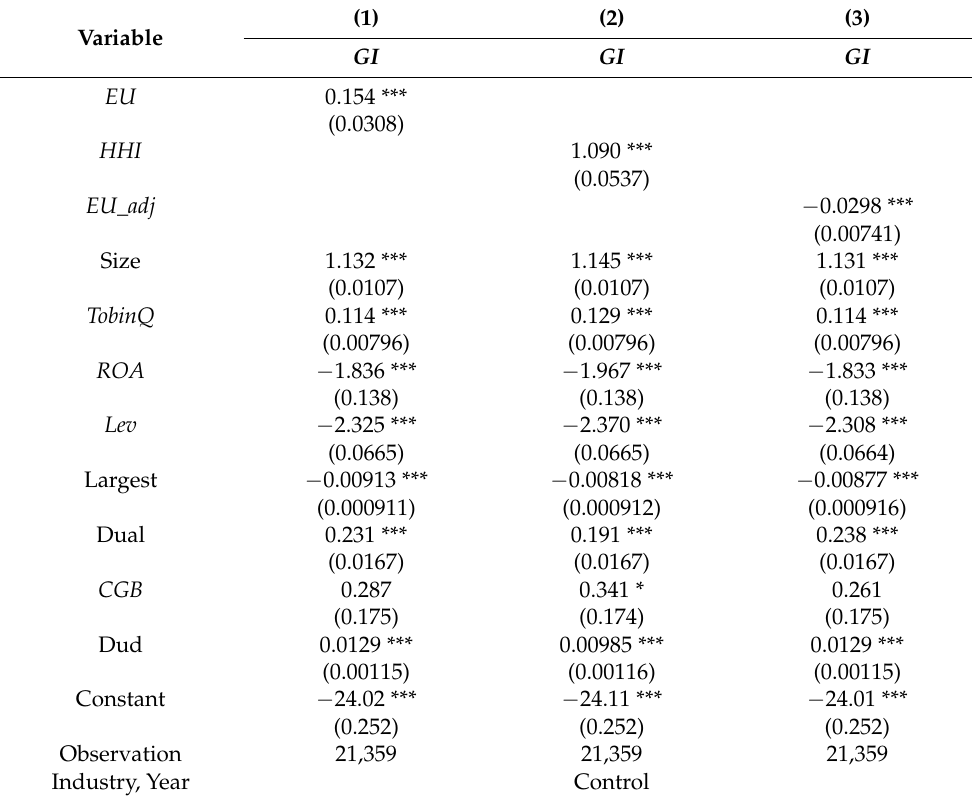
Table A5. Robustness Analysis of Environmental Uncertainty and Enterprises’ Green Technological Innovation Based on Poisson Regression.